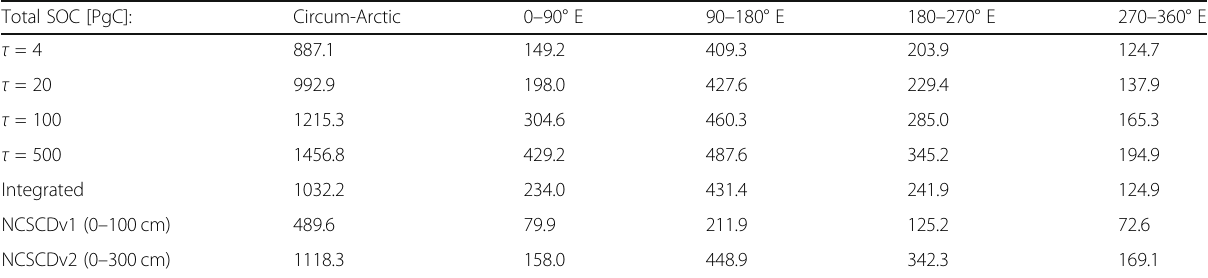
Table 1 Total amount of simulated SOC and ground ice in the circum-Arctic region Total SOC